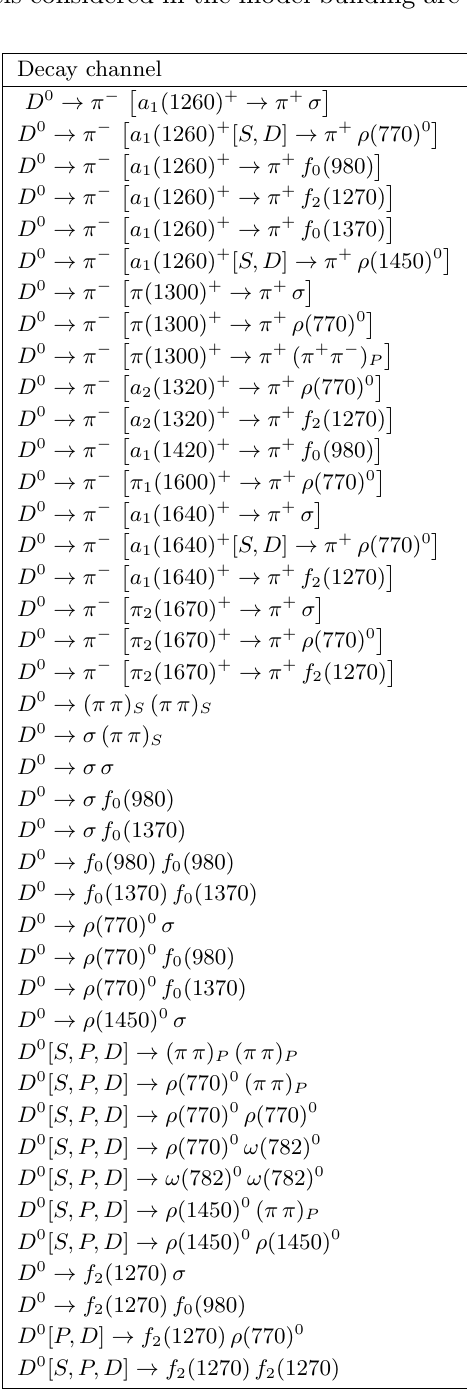
Table 16 . Decays considered in D 0 ! (cid:25) + (cid:25) (cid:0) (cid:25) + (cid:25) (cid:0) LASSO model building. For cascade non-self- conjugate channels, the conjugate partner is